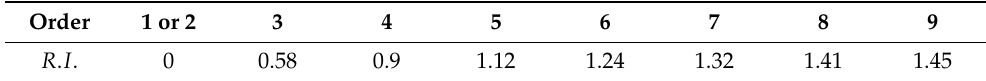
Table 2. Values of R . I . in judgment matrix.